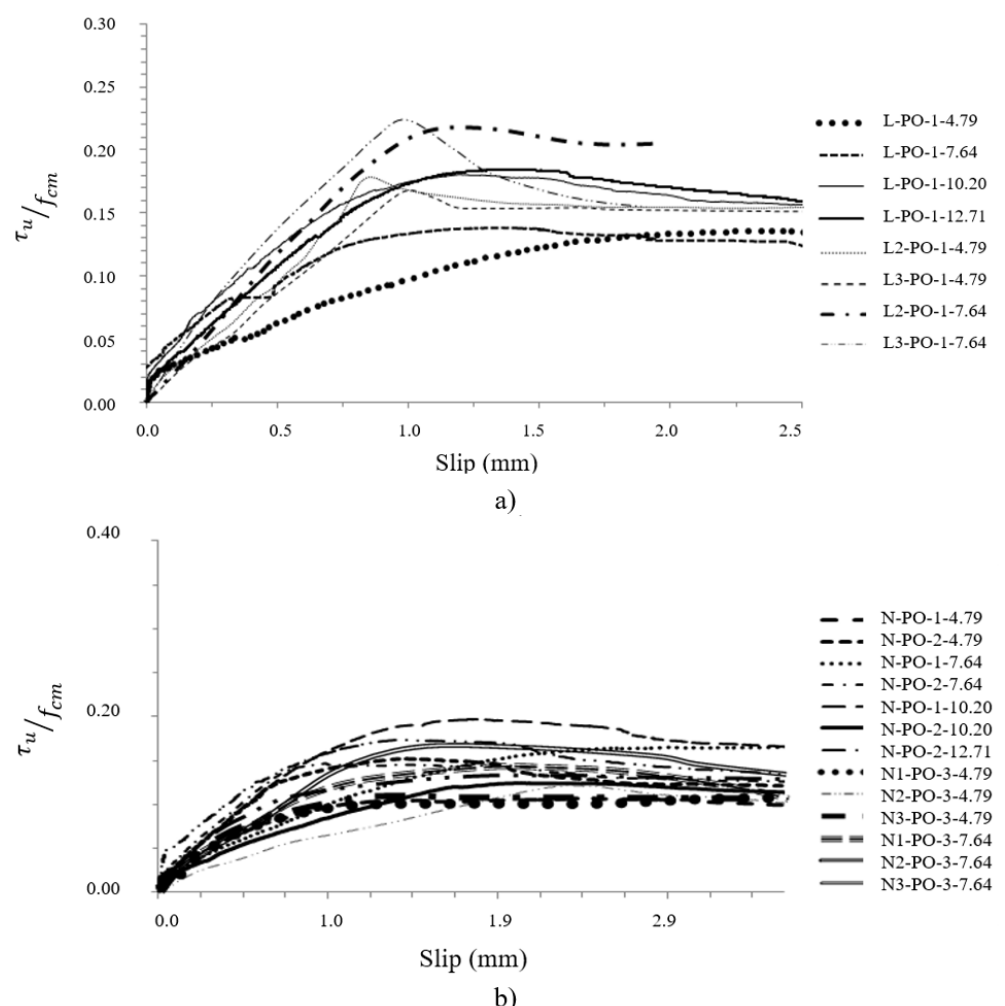
Figure 9. Normalized shear stress vs. slip curves: a) sand-lightweight concrete; b) conventional high-strength